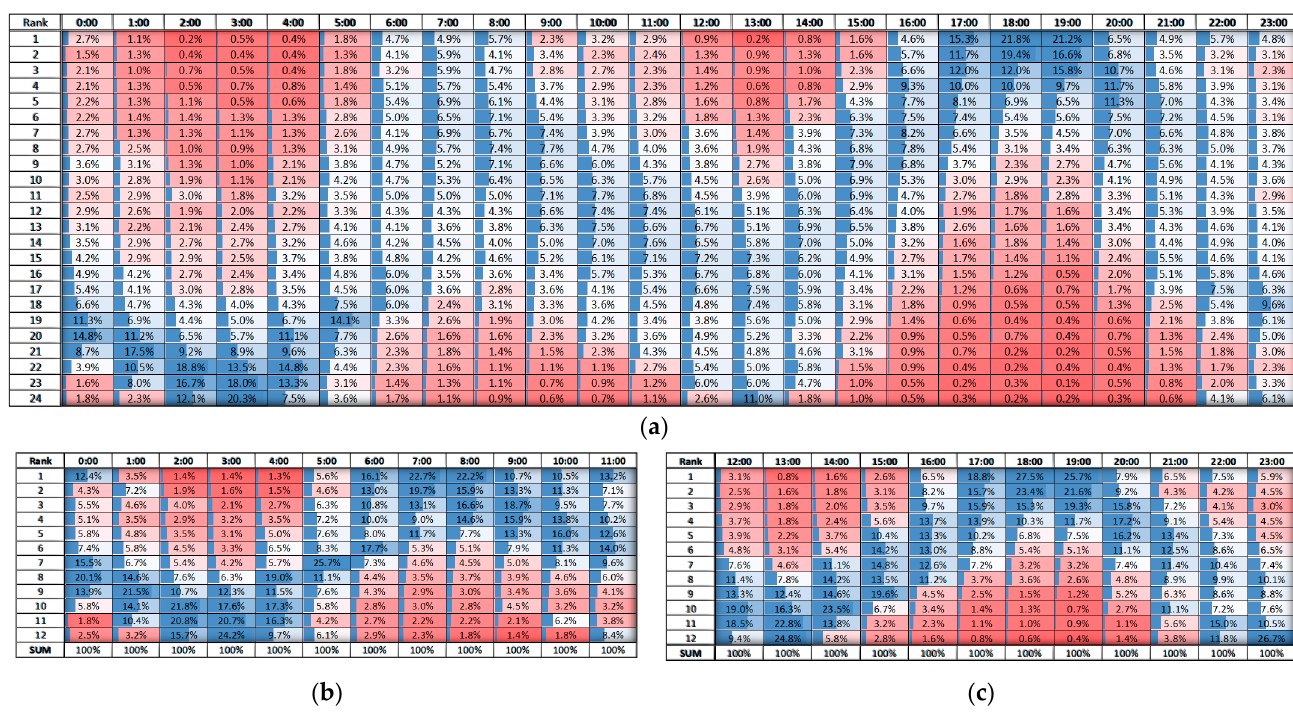
Figure 6. Probability mapping of hours’ price rankings—day-ahead ( a ) and intraday ( b , c ). According to our analysis of the daily cycling routine, hours with the lowest ranking appear between 2:00 and 4:00 at night (blue shade), while hours with the highest ranking appear from 17:00 to 19:00 in the afternoon. With regards to the intraday analysis, for the fi rst half of the day (00:00–11:00), hours with the lowest ranking correspond to 2:00 to 4:00 at dawn, while hours with the highest one appear from 6:00 to 8:00 in the morning. Finally, for the second half of the day (12:00–23:00), hours with the lowest ranking are at 22:00, 23:00, and 13:00, while hours with the highest ranking are from 17:00 to 19:00 in the after- noon.